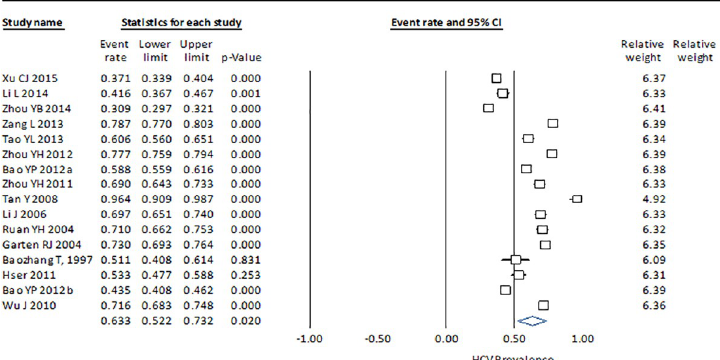
Fig 2. Forrest plot of random effects model to estimate HCV prevalence in IDU population in